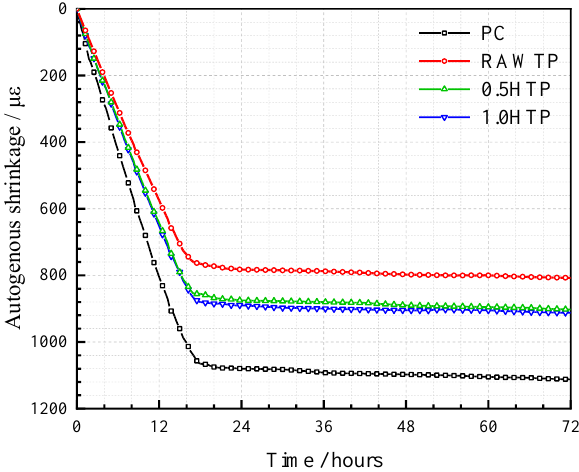
Figure 16. Autogenous shrinkage results of cementitious pastes.